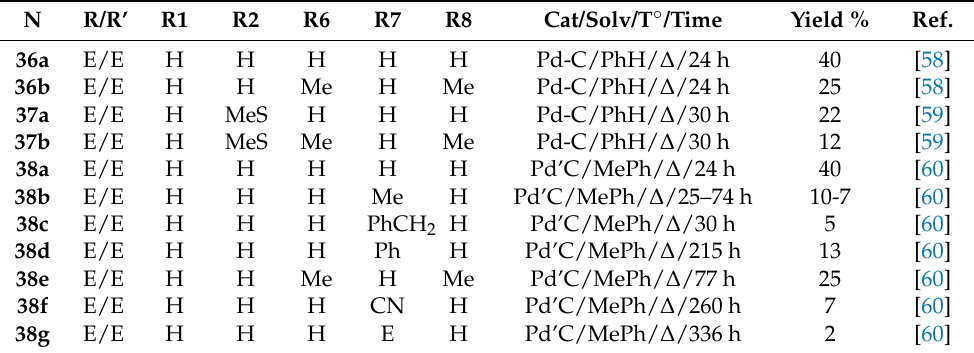
Table 8. Substituents, conditions and yields in cycloaddition of acetylene acetylenes to 3-CN-sub- stituted indolizines giving cyclazines (Scheme 16).